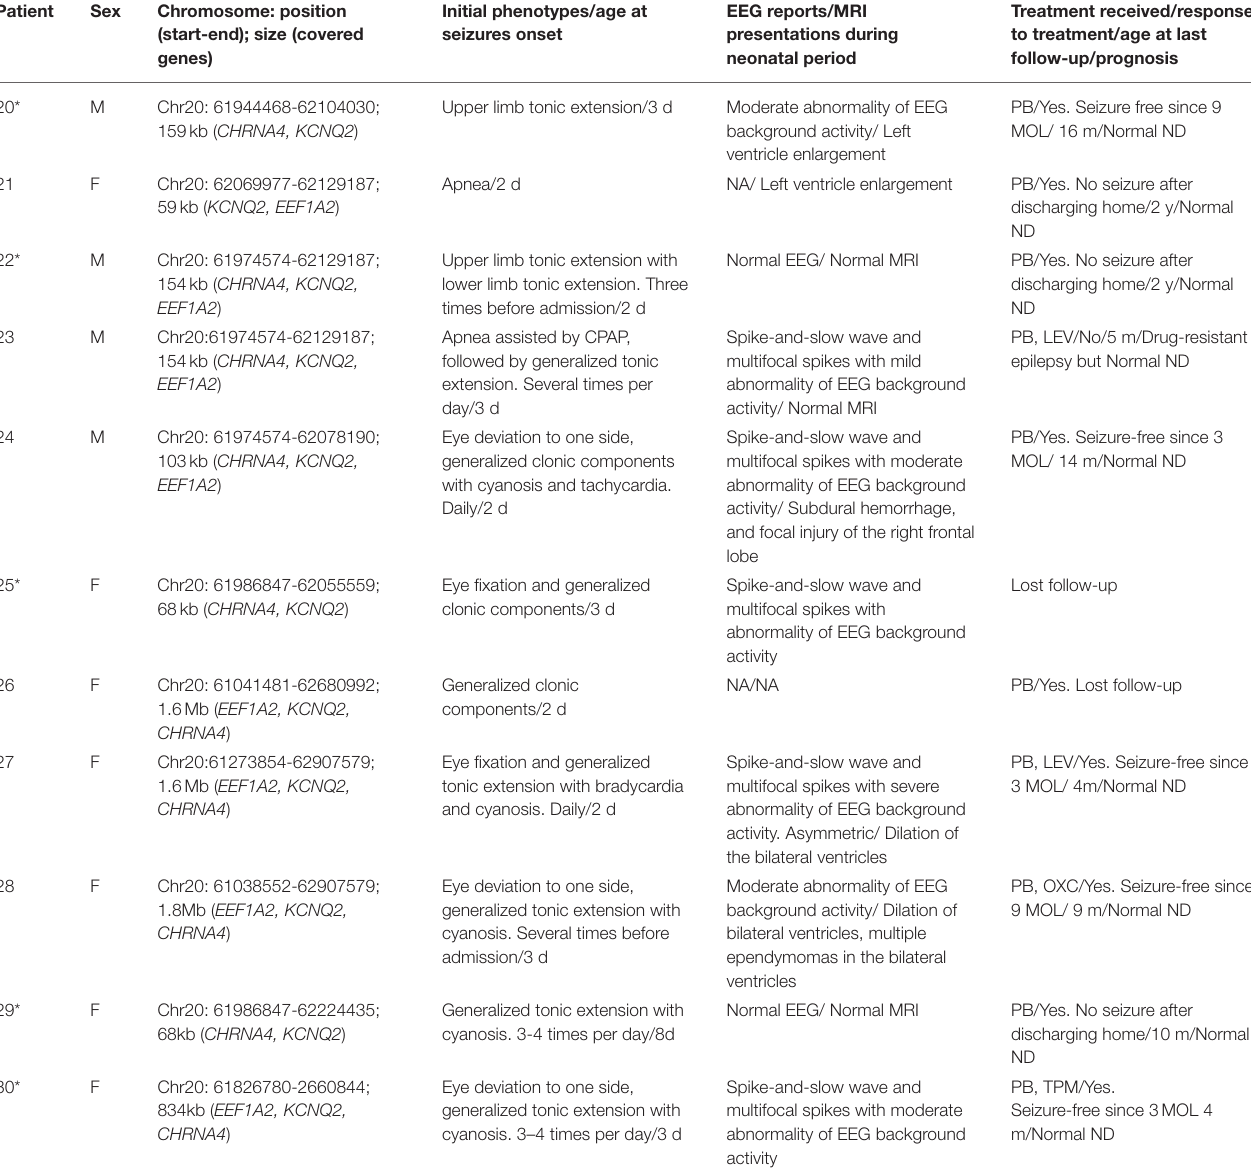
TABLE 2 | Novel deletion in KCNQ2 gene identified in 11 neonates with KCNQ2 -related disorders.